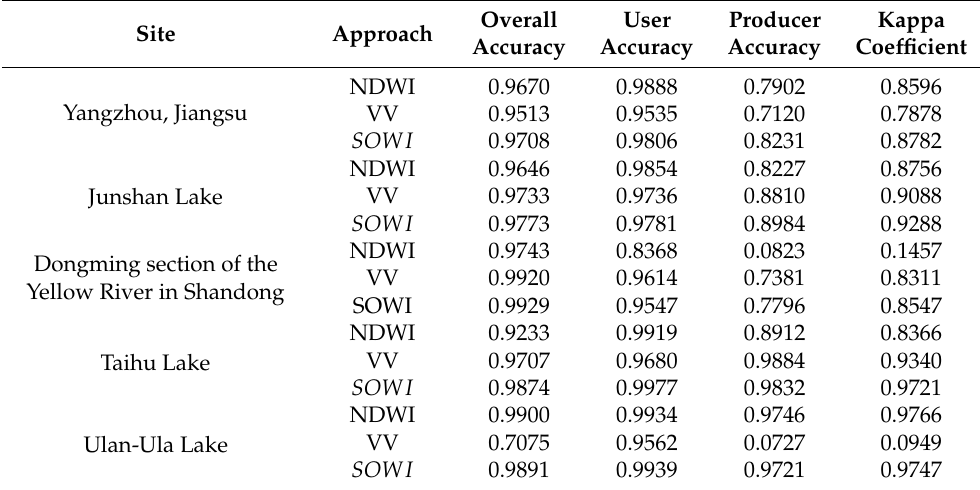
Table 2. Summary of accuracy assessments at the five main test sites including various accu- racy